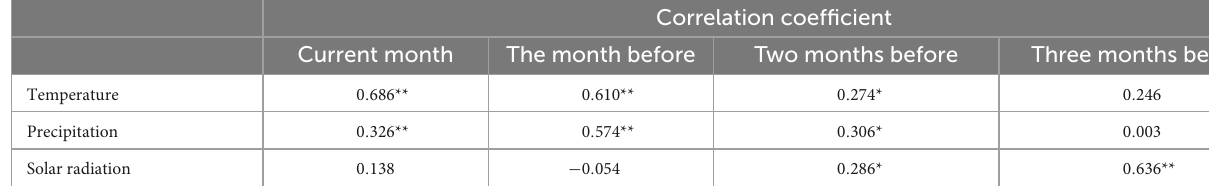
TABLE 2 Lag analysis of climate factors in different months on normalized difference vegetation index (NDVI).